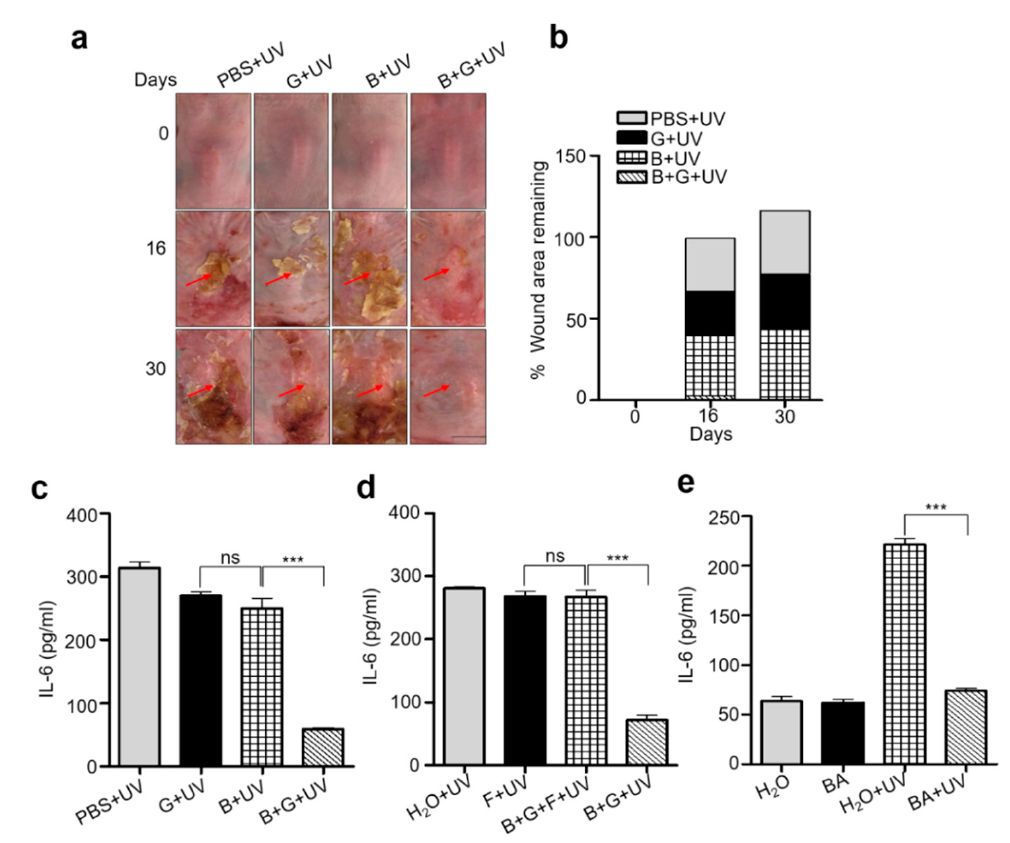
Figure 3. Attenuation of UVB induced inflammation by application of mixture of S. epidermidis and glycerol and its fermentation metabolite, butyric acid. ( a ) Skin morphology of ICR mice, topically applied with PBS, glycerol (G) (2%), S. epidermidis bacteria (B) (10 7 CFU / mL), or mixture of S. epidermidis bacteria plus glycerol (B + G) followed by exposure with UVB (195 mJ / cm 2 ) irradiation are shown at 0, 16, and 30 day. Skin lesions are indicated by red arrows. Scale bar = 5 mm. Graph ( b ) indicates percent wound area remaining of mice skin. The level of IL-6 in skin ( c ) from above all groups of ICR mice was quantified using a mouse IL-6 enzyme-linked immunosorbent assay (ELISA) kit (R&D Systems). ( d ) The IL-6 level in skin of ICR mice topically applied with H 2 O, furfural (0.4%), S. epidermidis bacteria (B) (10 7 CFU / mL), glycerol (G) (2%) plus furfural (F) (0.4%), (B + G + F) or a mixture of S. epidermidis bacteria plus glycerol (B + G) followed by exposure with UVB (195 mJ / cm 2 ) irradiation is shown. ( e ) The IL-6 level in skin of ICR mice topically applied with H 2 O and butyric acid (BA) (4 mM) followed by exposure with UVB (195 mJ / cm 2 ) irradiation is shown. Data are the means of three individual experiments using five mice per group. ns = non-significant. *** p < 0.001. (two-tailed t